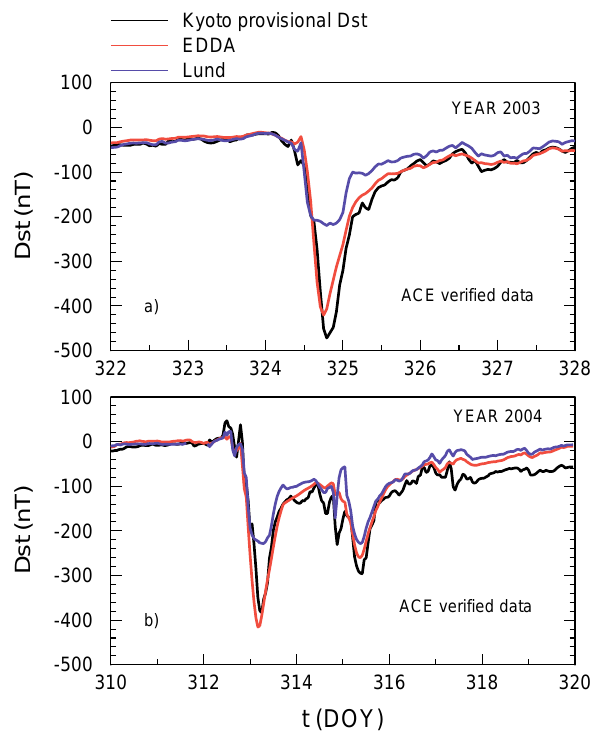
Fig. 7. Comparison of the EDDA (red lines) and “Lund (blue lines)” D st predictions with the Kyoto provisional D st index (black line) for two recent storms. In both panels the model D st is calculated from ACE verified